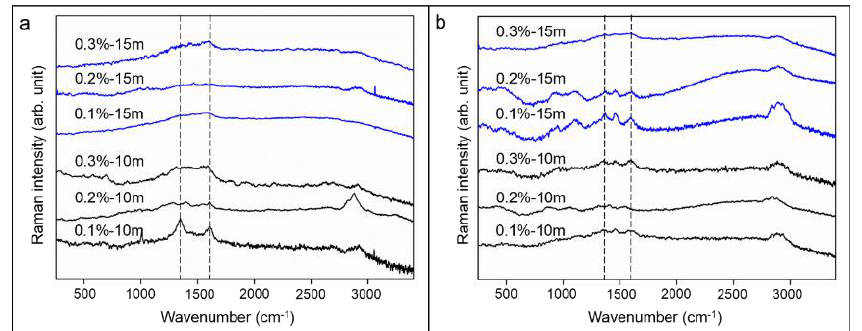
Figure 8. Raman signal on ( a ) the surface of chrome steel ball and ( b ) in the wear scar.